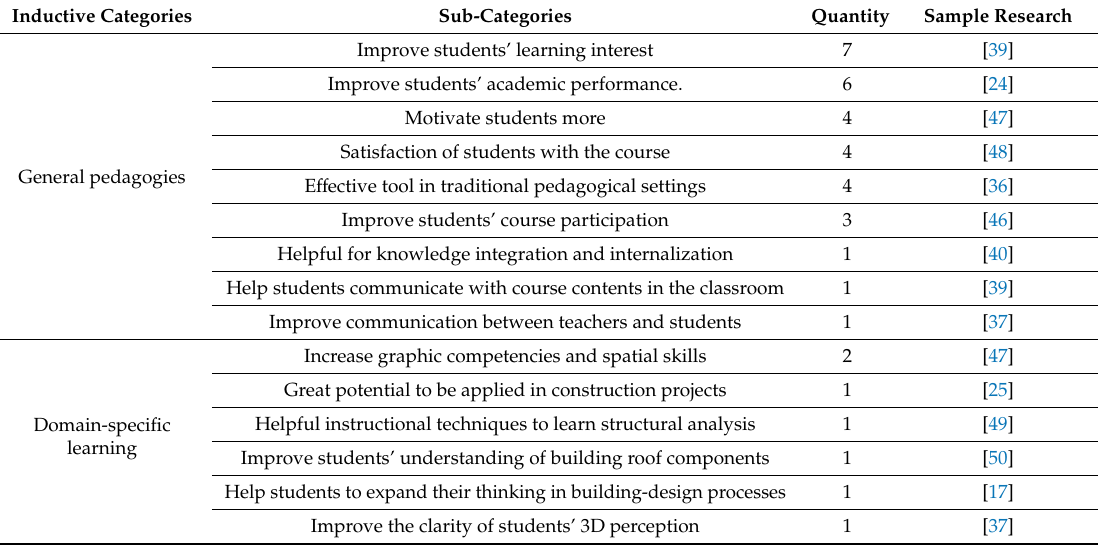
Table 3. The advantages of AR in ACE education curriculums.